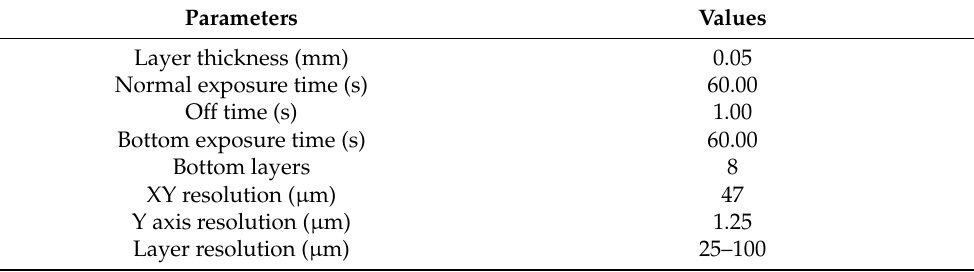
Table A2. 3D printer setting parameters for 3D printed